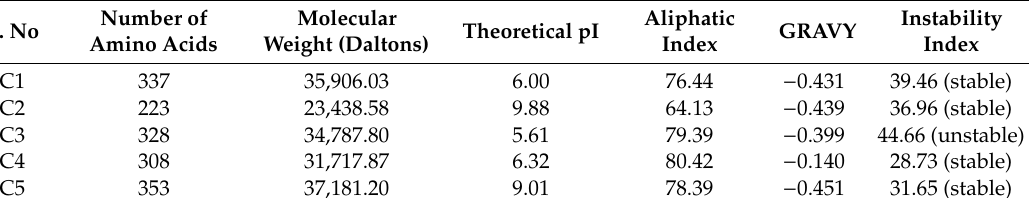
Table 4. Physiochemical properties of the vaccine constructs.